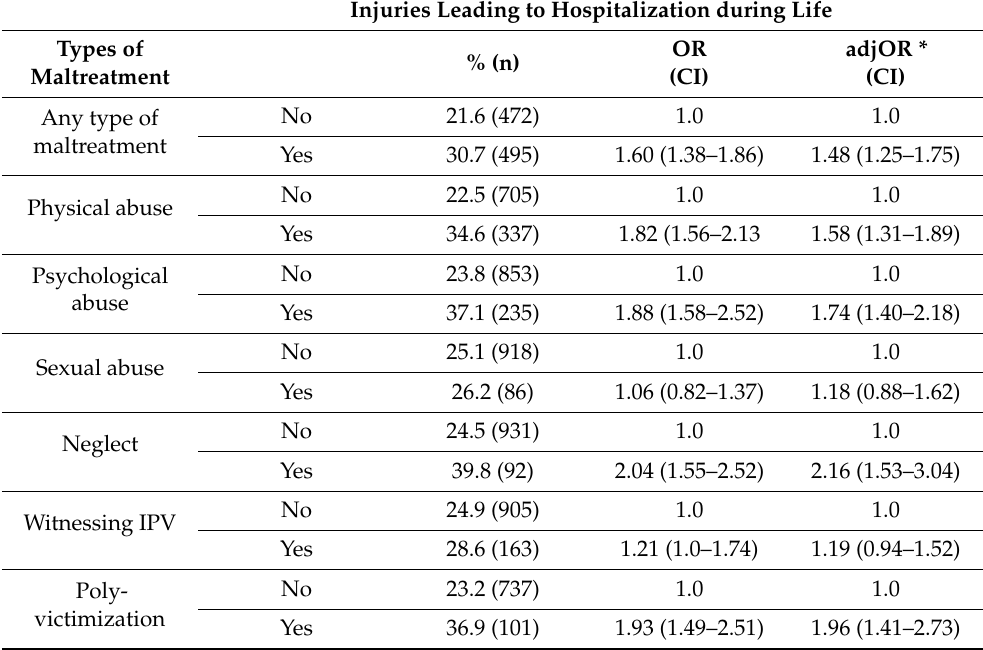
Table 4. The association between different types of child maltreatment (during life) and self-reported unintentional injuries leading to hospitalization during